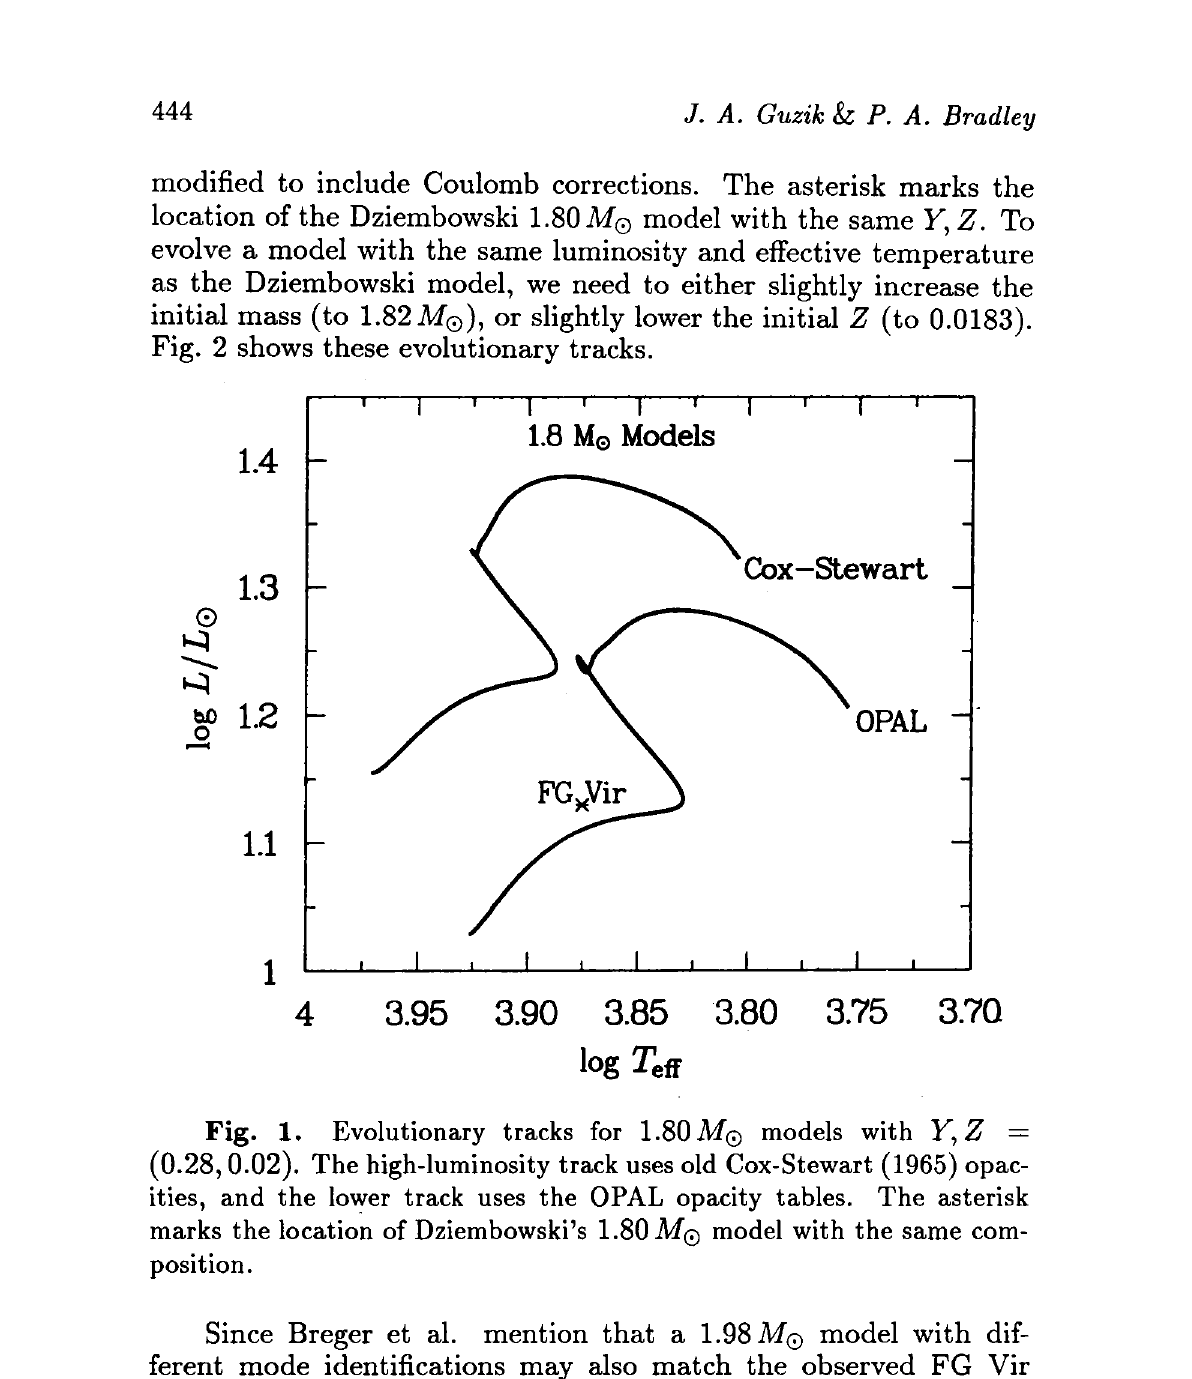
Fig. 1. Evolutionary tracks for 1.80 M© models with Y ,Z = (0.28, 0.02). The high-luminosity track uses old Cox-Stewart (1965) opac- ities, and the lower track uses the OPAL opacity tables. The asterisk marks the location of Dziembowski's 1.80 M© model with the same com-